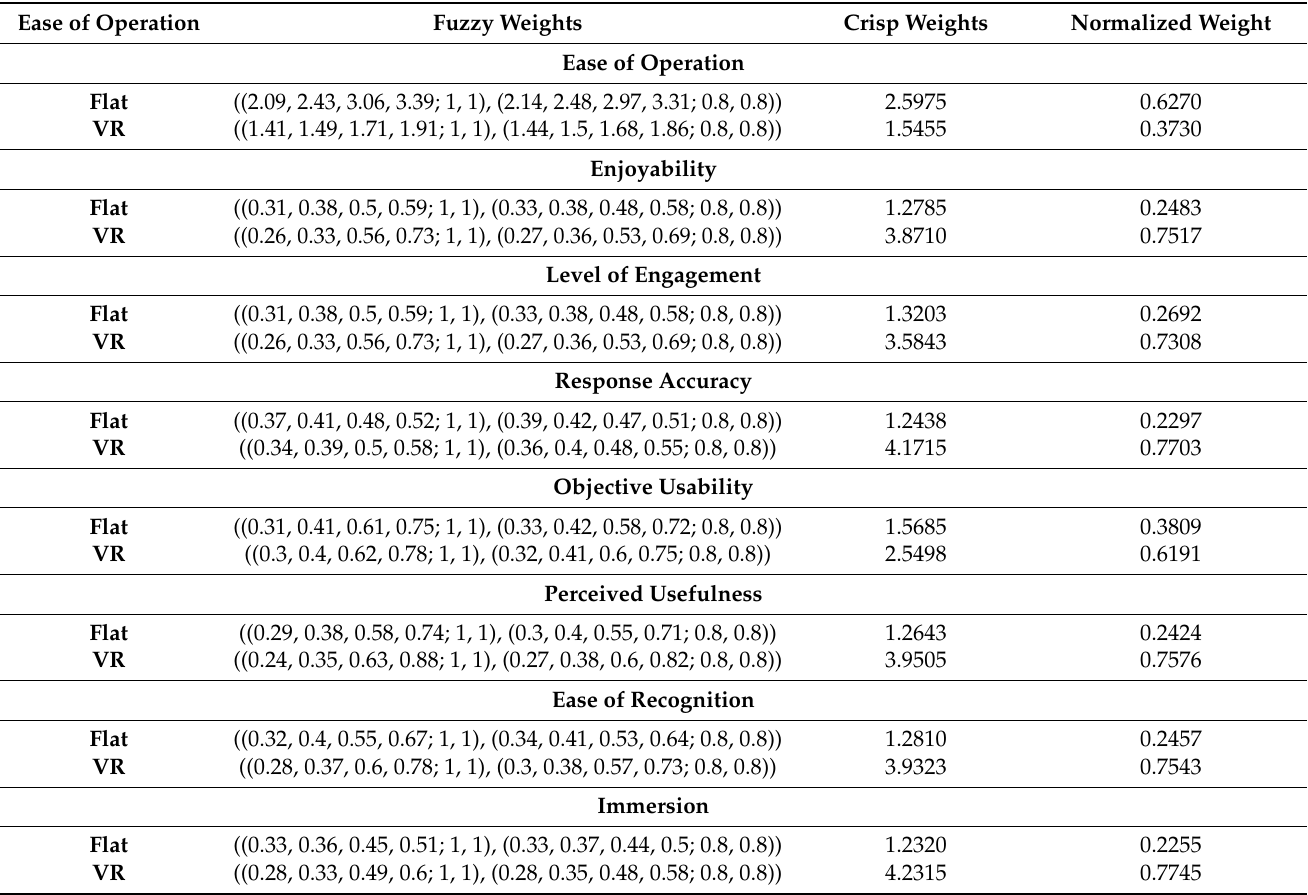
Table 9. Subfactor weights with respect to